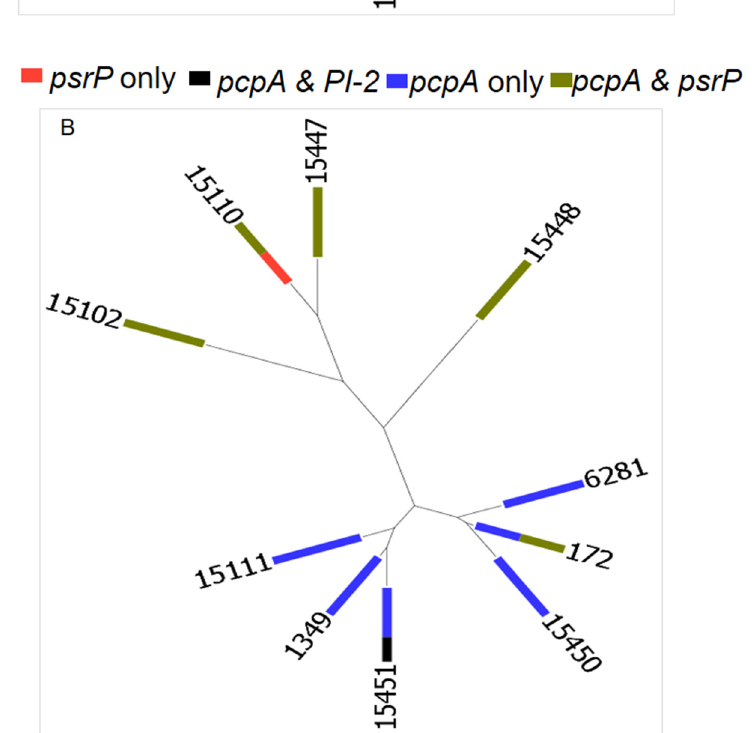
Figure 3. Relationship between STs, multidrug resistance and virulence genes. The neighbor-joining tree (NJT) was generated using PHYLOViZ. ( A ) Multidrug-resistance (MDR) relationship among the different STs. MDR was detected in both new and existing STs. ( B ) Distribution of virulence genes by STs. There was a fair distribution of all the virulence genes among the identified STs except the pilus islet 2, which was limited to only ST15451.